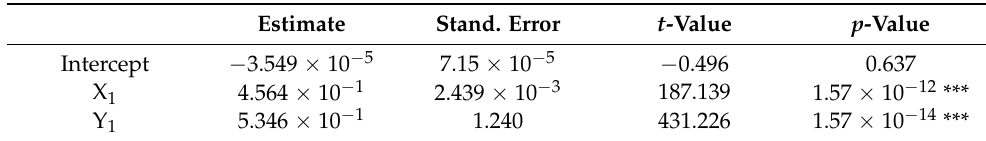
Table 1. Coefficients of MLRM for the experimentally fixed rate constant at 420 ◦ C with a difference of 0.02. Where ‘***’ shows a statistically significant